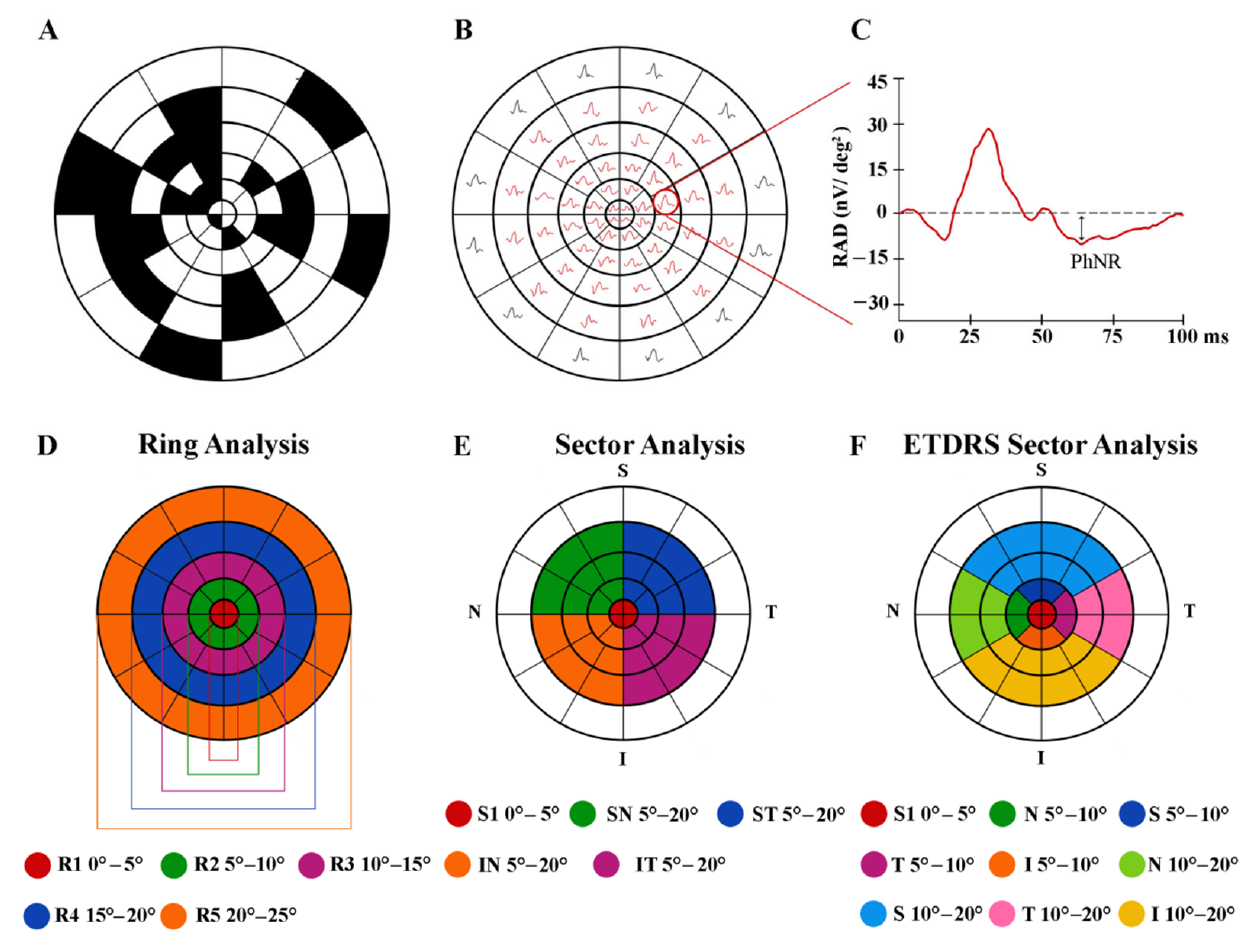
Figure 1. Multifocal photopic negative response (mfPhNR) stimulus ( A ) consisting of a circular dartboard of 60 elongated scaled elements and the relative obtained trace array ( B ) subtending 30 ◦ of the visual field from a representative control eye. The average response amplitude density (RAD) of the mfPhNR expressed in nanoVolt/degree 2 (nV/deg 2 ) ( C ) was measured as baseline-to-trough with an implicit time between 50 and 90 milliseconds (ms) from the stimulus onset. In the analysis of mfPhNR responses, we considered three different topographies. ( D ) The ring analysis analyzes mfPhNR RADs from five concentric annular areas (rings, R) with increasing eccentricity from the fovea, depicted in different colors: ring 1 (R1) in red from 0 ◦ to 5 ◦ ; ring 2 (R2) in green 5 ◦ to 10 ◦ ; ring 3 (R3) in purple from 10 ◦ to 15 ◦ ; ring 4 (R4) in blue from 15 ◦ to 20 ◦ ; and ring 5 (R5) in orange from 20 ◦ to 25 ◦ . ( E ) The sector analysis, covering an area of 20 ◦ of foveal eccentricity, analyzes RAD responses recorded from S1 (corresponding to R1, in red, see above), a circular area of 5 ◦ of centered on the fovea, and from the more external quarters of annulus within 5 ◦ and 20 ◦ , localized in the superior-temporal (ST, in blue), superior-nasal (SN, in green), inferior-nasal (IN, in orange), and inferior-temporal (IT, in purple) areas with respect to the fovea. ( F ) The ETDRS sector analysis analyzes the mfPhNR responses from nine sectors corresponding to the ETDRS map configuration. The central sector corresponds to the R1 of the ring analysis and to S1 of the sector analysis (in red, see above); the external sectors analyze the superior (S, in blue), temporal (T, in purple), inferior (I, in orange), and nasal (N, in dark green) areas within 5 ◦ and 10 ◦ from the fovea; and the outermost sectors analyze the S (in light blue), T (in pink), I (in yellow), and N (in light green) sectors within 10 ◦ and 20 ◦ from the fovea.